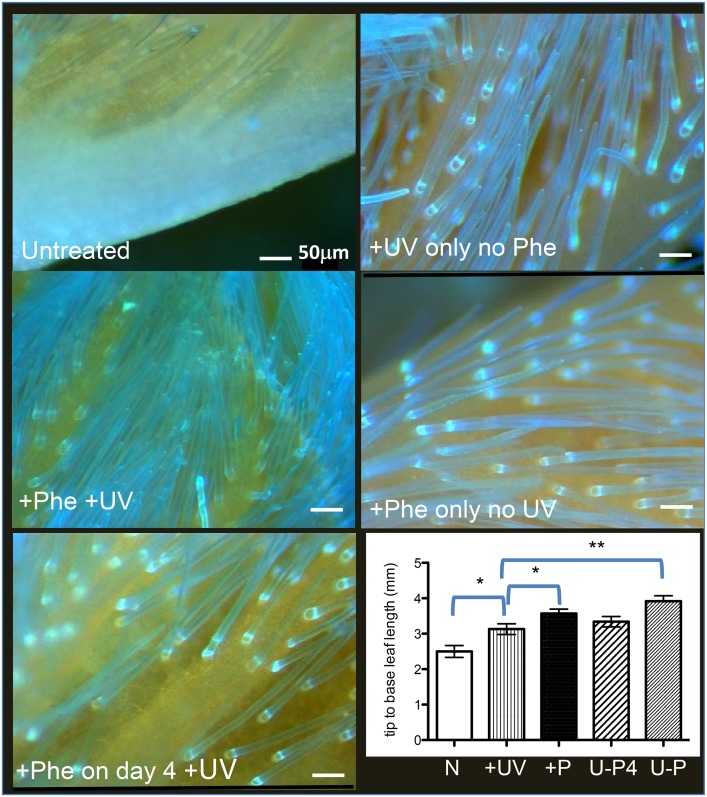
Primary leaves respond to Phe or UV (317 nm): impact on pubescence and leaf expansion.All data shown are from 5-d-old seedlings (4-d-old seedlings were irradiated with 317 nm, returned to darkness, then images captured 24 h later), and images were taken on a Stereo dissecting microscope utilizing a DAPI-longPass cube set, with excitation peak at 325 nm and emissions that covered the full visible spectrum (in real color). Images were captured at the same exposure. The Control (“Untreated” image; “N” tip to base leaf length) seedlings were not treated by any UV irradiation, and the medium did not contain Phe at any time. “+Phe +UV” image, “U-P” tip to base leaf length indicates data set where Phe was included in the medium from sowing, and 4-d-old seedlings were irradiated with 317 nm then returned to darkness and harvested 24 h later. “+Phe only no UV” image; “+P” tip to base leaf length were seedlings treated with Phe alone in the medium from sowing, harvested at the same time as all other seedlings (24 h irradiation times). “+UV only no Phe” image, “+UV” tip to base leaf length are seedlings receiving a 317 nm UV irradiation without any Phe at any time, returned to darkness and harvested 24 h post-irradiation. “+Phe on day 4 +UV” image; “U-P4” tip to base leaf length indicate seedlings grown in the same manner as controls, until 4-d-old seedlings, where Phe was added to the medium 1.0 h before the UV (317 nm) irradiation, returned to darkness, then viewed 24 h later. All seedlings thus were the exact same age (5-d-old). The red flourescence indicates protochlorophylls and developing plastids from developing mesophyll under the epidermis. n = 30 seedlings each condition. The scale bar represents 50 µm. (* = P<.05; ** = P<.01).